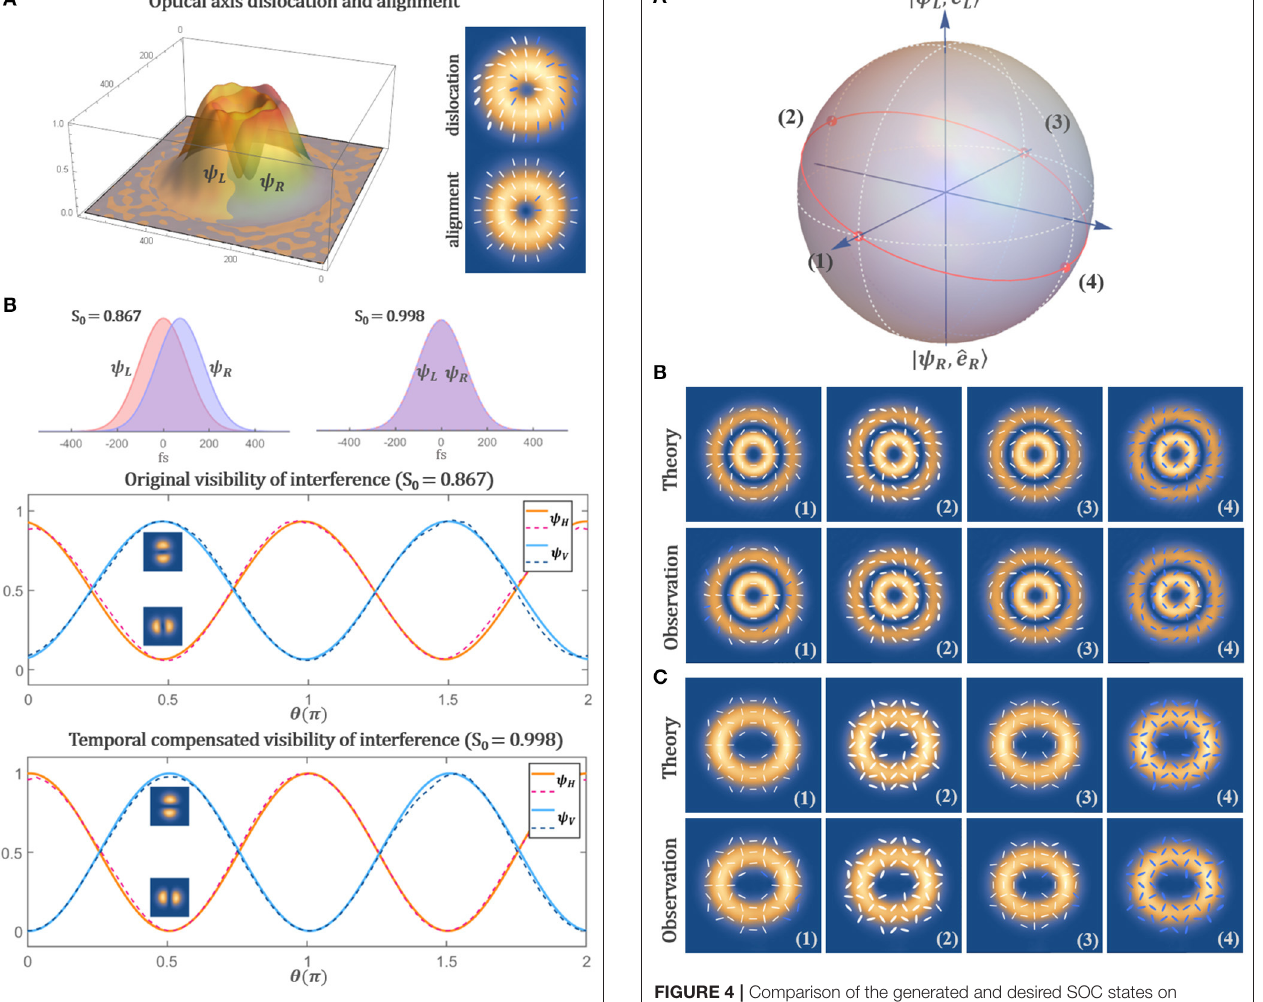
blazed grating. In the experiment, the grating period is 200 µ m, the incident angle is within 5 ◦ , and the beam distance is 5